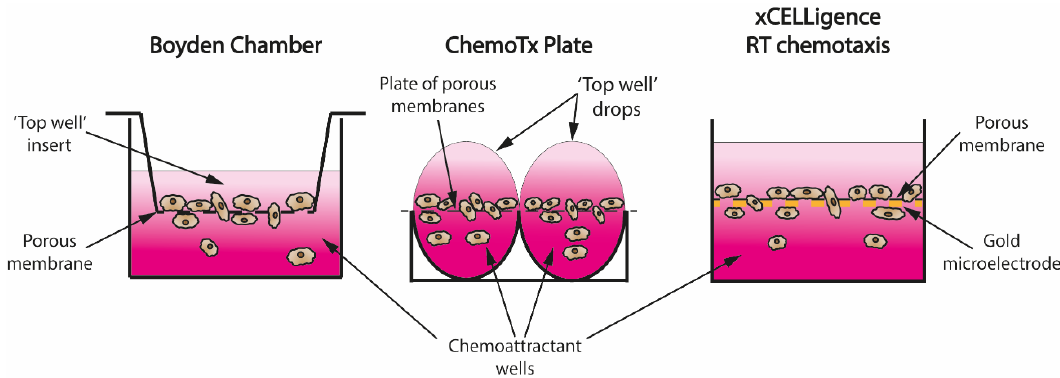
Figure 2. Evolution of the transwell assay design. ( left ) The original Boyden Chamber, created in 1962, consisted of a well-filled chemoattractant solution into which a ‘top well’ insert was placed with cells seeded in pure cell media. Due to simple diffusion, a chemoattractant gradient was created (represented by pink gradient) that induced directional migration of cells through the pores into the chemoattractant well; ( middle ) ChemoTx plates aimed at reducing high inter-well variability and high volumes of solution required with Boyden chamber by replacing individual inserts with one big porous membrane overlaying the entire 96 well plate; drops of cell suspension were placed directly onto the membrane over the chemoattractant wells to create a gradient via simple diffusion and allow cells to migrate through the pores; ( right ) xCELLigence Real Time Chemotaxis assay allowed collection of real-time kinetic data for the first time in transwell assays by attaching a gold microelectrode to the bottom of the porous membrane. Migration was quantified by measuring cell impedance of the cells that migrated through the pores and attached to the bottom of the membrane.